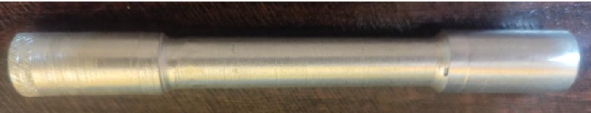
Fig. 4. Sample of the tensile test